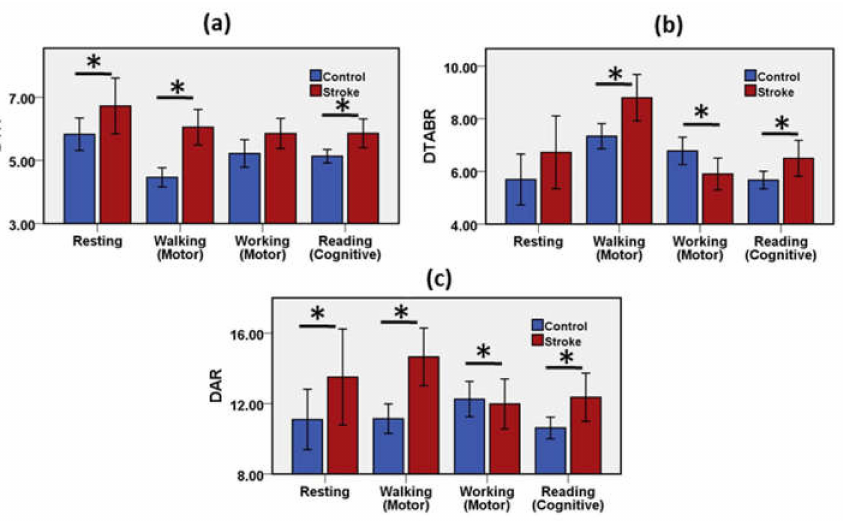
Figure 6. Mean and error bar of ( a ) DTR, ( b ) DTABR, ( c ) DAR of the stroke group and the control group during resting, motor, and cognitive tasks. Error bar shows 95% confidence interval. * ( p < 0.05) indicates a significant